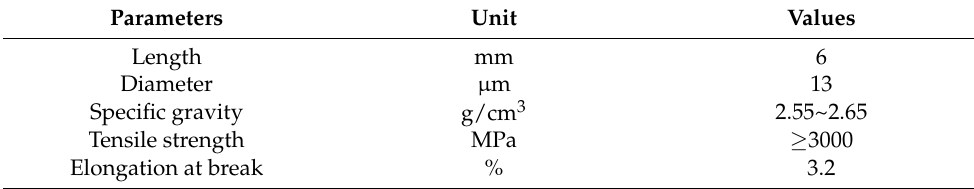
Table 5. Basic performances of basalt